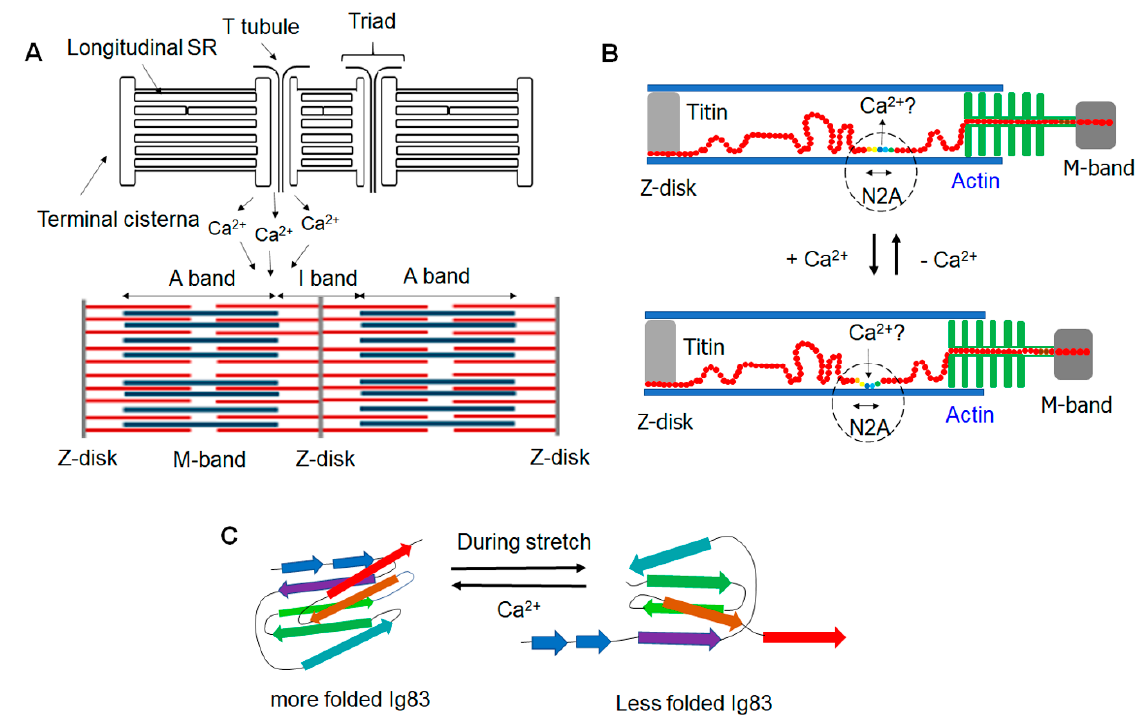
Figure 2. Calcium ion’s interactions with the N2A domain of titin during contractions and stretching. ( A ) Alignment of the sarcomere and sarcoplasmic reticulum (SR). The SR stores and releases calcium ions toward the sarcomere. The triad structure made of the SR and T-tubules overlaps with the sarcomere’s A-I junction close to the N2A region of titin. ( B ) The potential role of calcium ion in the N2A–actin-filament interactions. The influx of Ca 2+ may enhance the N2A’s binding with actin filaments, which needs additional investigation due to conflicting data. ( C ) The role of calcium ion in stabilizing the N2A’s sub-domain. The Ig83 domain is stabilized and keeps a more folded structure in the presence of calcium ion, whereas it may be subjected to unfolding during stretches of titin. ( A ) was adapted and redrawn from Rossi et al.’s publication [51].